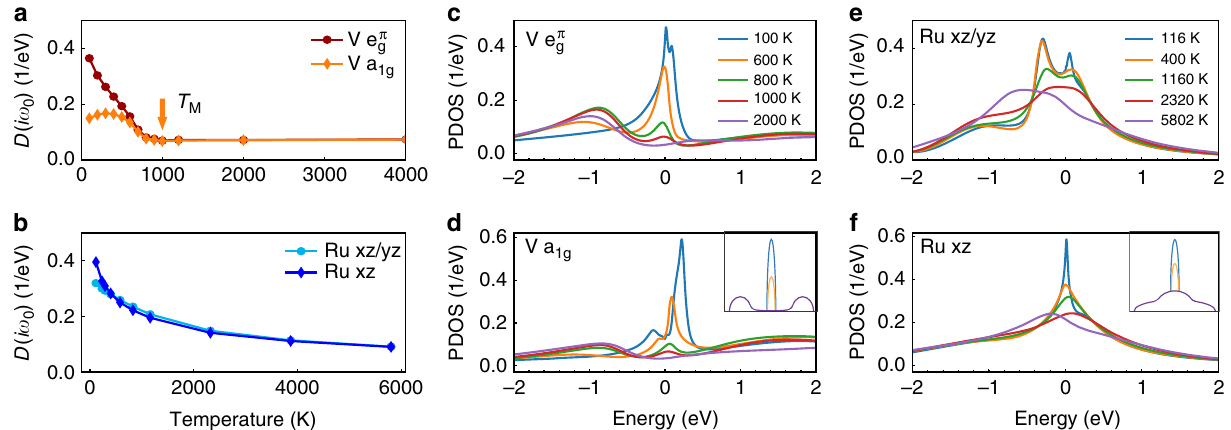
Fig. 2 Local spectra of the correlated orbitals in V 2 O 3 and Sr 2 RuO 4 . The results for V 2 O 3 ( a , c , d ) and Sr 2 RuO 4 ( b , e , f ) exhibit very different temperature- dependent behaviors. a , b The density of states at the Fermi level, estimated by D ð i ω 0 Þ ¼ (cid:5) 1 π Im G ð i ω 0 Þ . c – f The correlated real-frequency spectra (PDOS), A ð ω Þ ¼ (cid:5) 1 π Im G ð ω Þ . D ( i ω 0 ) shows a suppression at a characteristic temperature T M = 1000 K (indicated by the orange arrow) in V 2 O 3 ( a ), while it evolves smoothly in Sr 2 RuO 4 ( b ). As temperature decreases, in V 2 O 3 the coherence resonance of both e π and a 1 g orbitals emerges from the pseudogap regime with g low density of states between two incoherent peaks ( c , d ), while in Sr 2 RuO 4 the coherence resonance of both d xz / yz and d xy orbitals emerges from a single broad incoherent peak with large fi nite density of states at the Fermi level ( e , f ). The insets in ( d , f ), repeated from Fig. 1, are cartoons of the